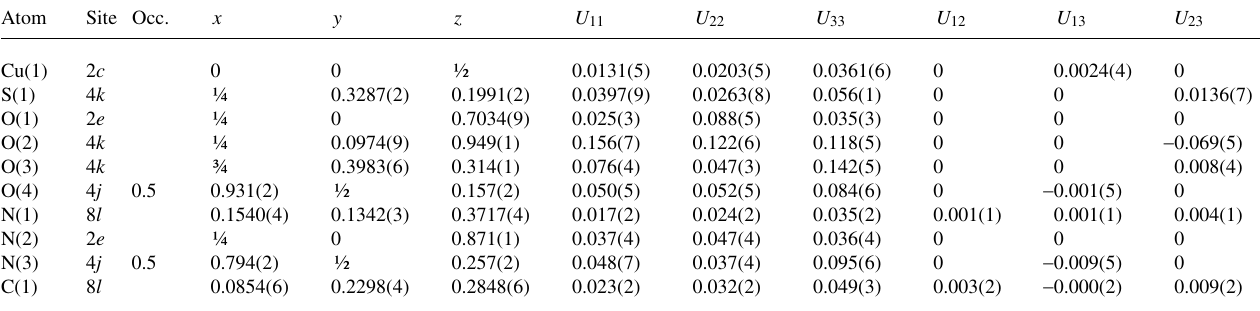
Table 3. Atomic coordinates and displacement parameters (in Å 2 ) .